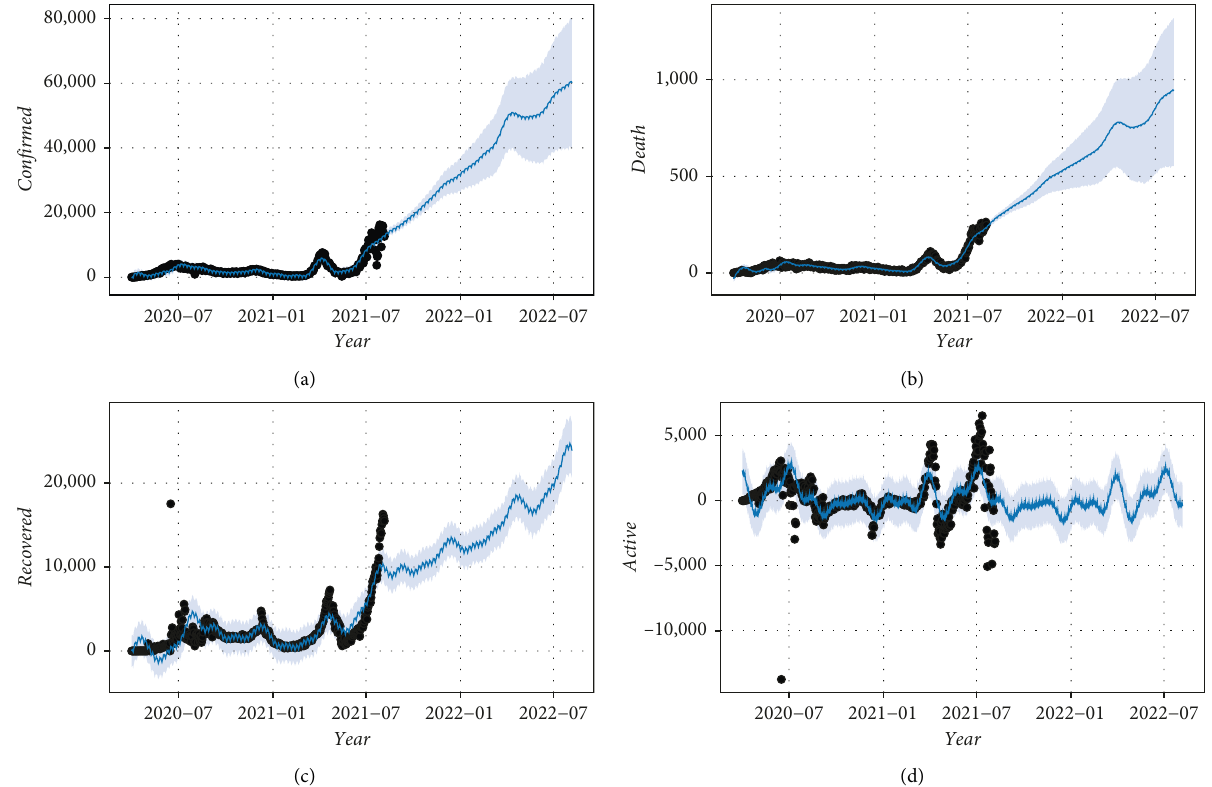
Figure 4: Time-series forecast plot using Facebook’s PROPHET Procedure for the COVID-19 outbreak in Bangladesh. Confirmed cases (a), death cases (b), recovered cases (c), and active cases